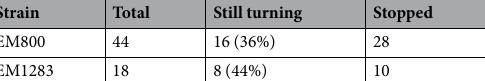
Table 1. Number and re-growth of filaments broken using an ultra-fast laser pulse. The rotation status of the filaments when we revisited them is also detailed. None of these 62 filaments continued to grow after being